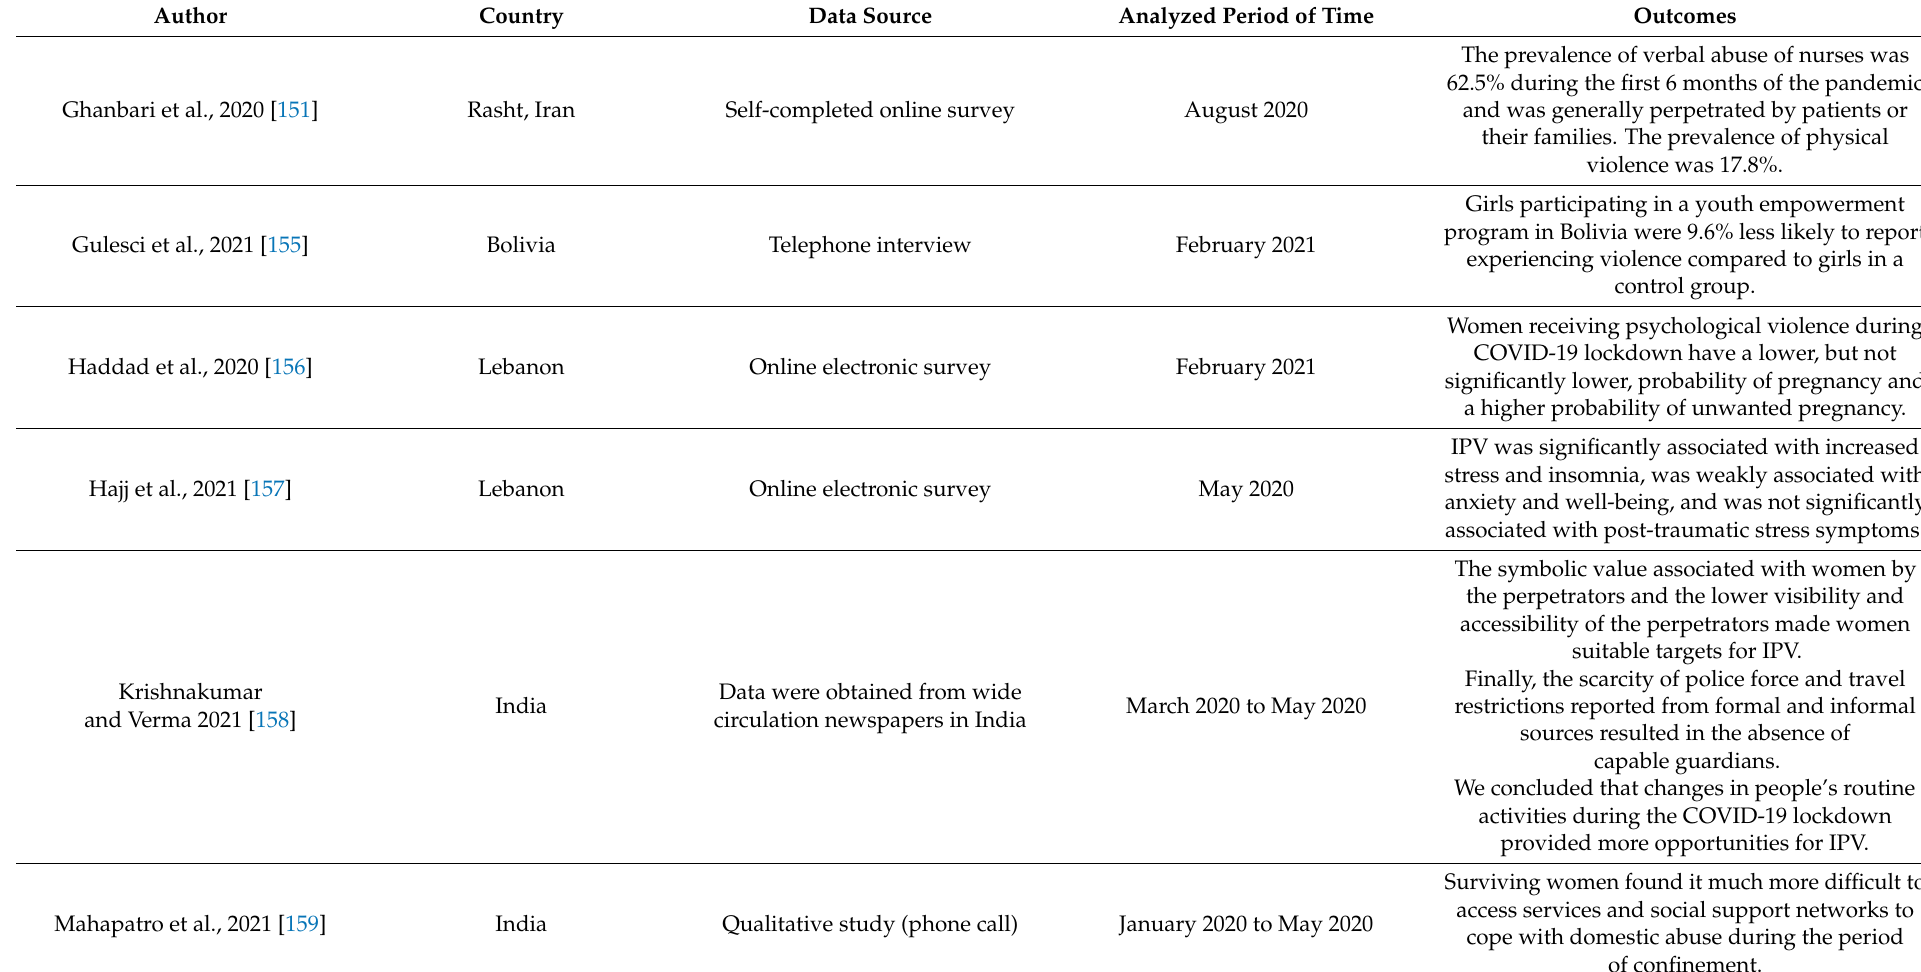
Table 2. Violence outcomes by country, data source and period time